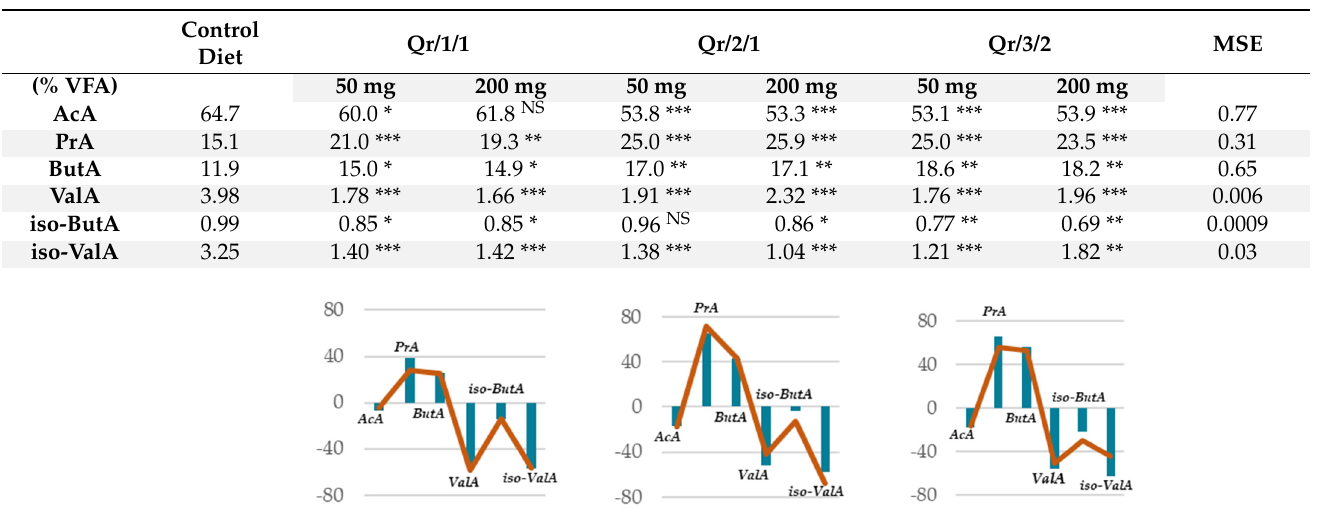
Table 5. Effects of Q. robur Qr/1/1 extract and its fractions Qr/2/1 and Qr/3/2 at 50-mg and 200-mg dose levels on fermentation end products after 120 h of incubation. AcA = acetic acid; PrA = propionic acid; ButA = Butyric acid; ValA = valeric acid; iso-ButA = iso-butyric acid; iso-ValA = iso- valeric acid. Along the row * p < 0.05, ** p < 0.01 and *** p < 0.001; NS: not significant; MSE: mean square error. In the lower panel, the percentage increase or decrease of each volatile fatty acid was plotted for different tested dose level ( ● 50 mg and ● 200 mg) vs. FA% in the control diet.